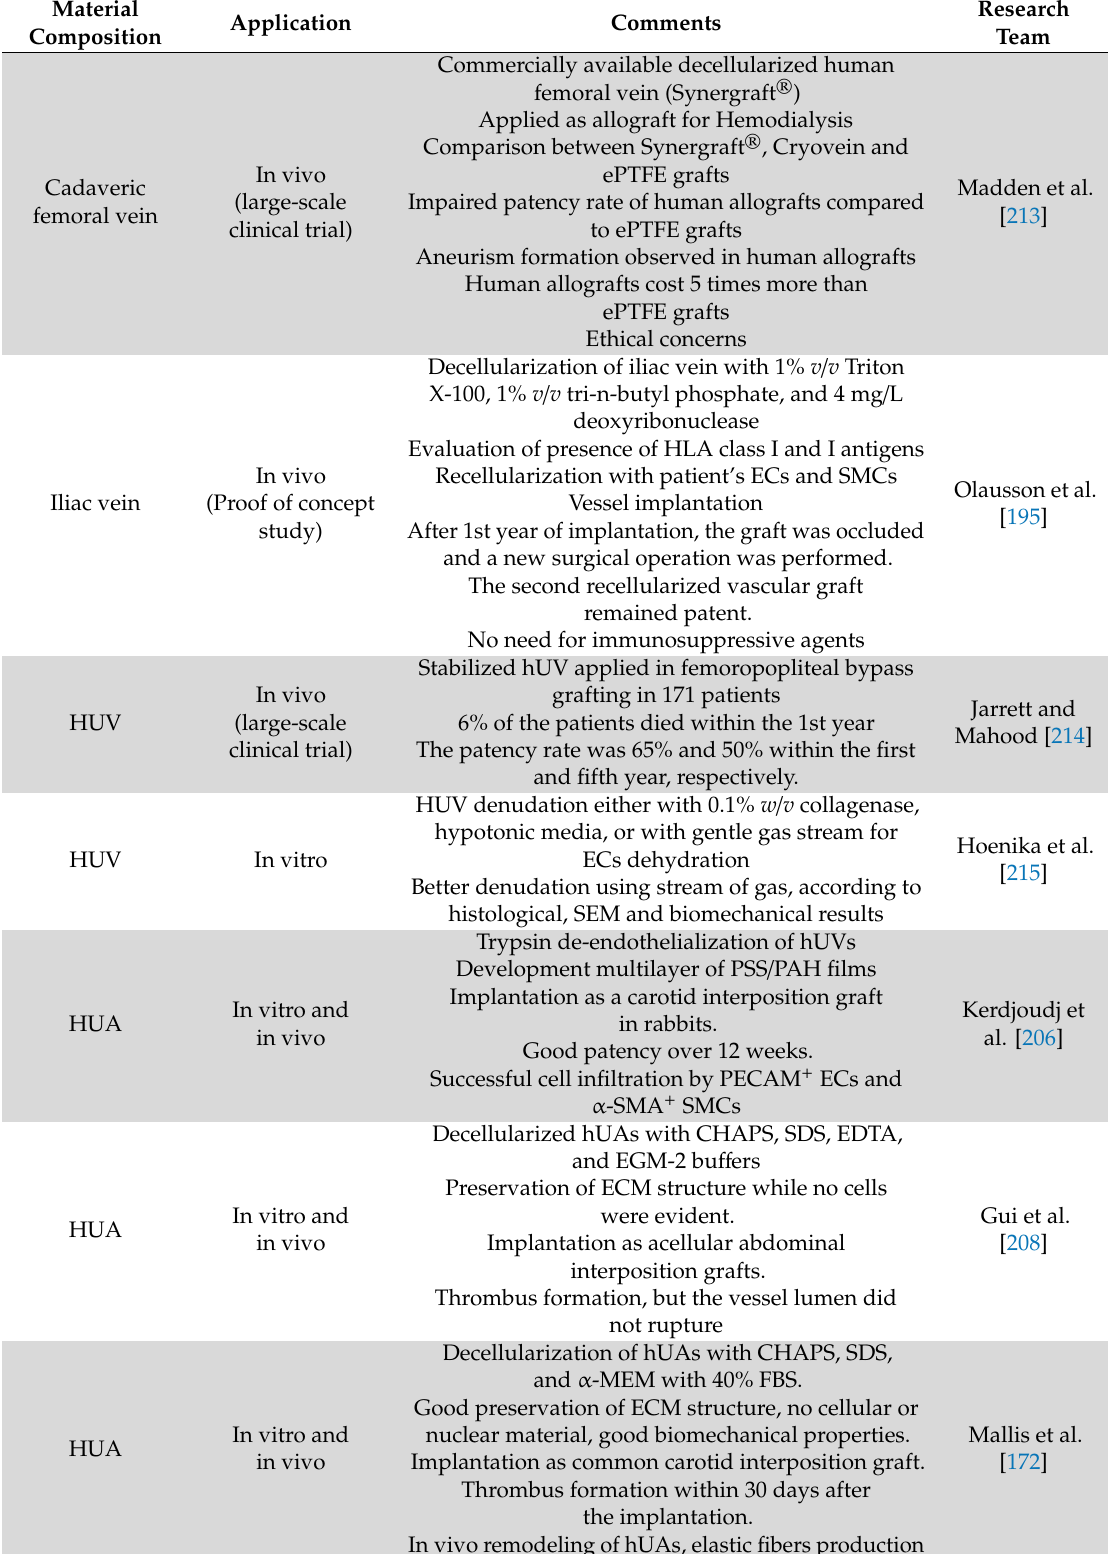
Table 6. Summary of representative studies toward decellularized human-derived vascular